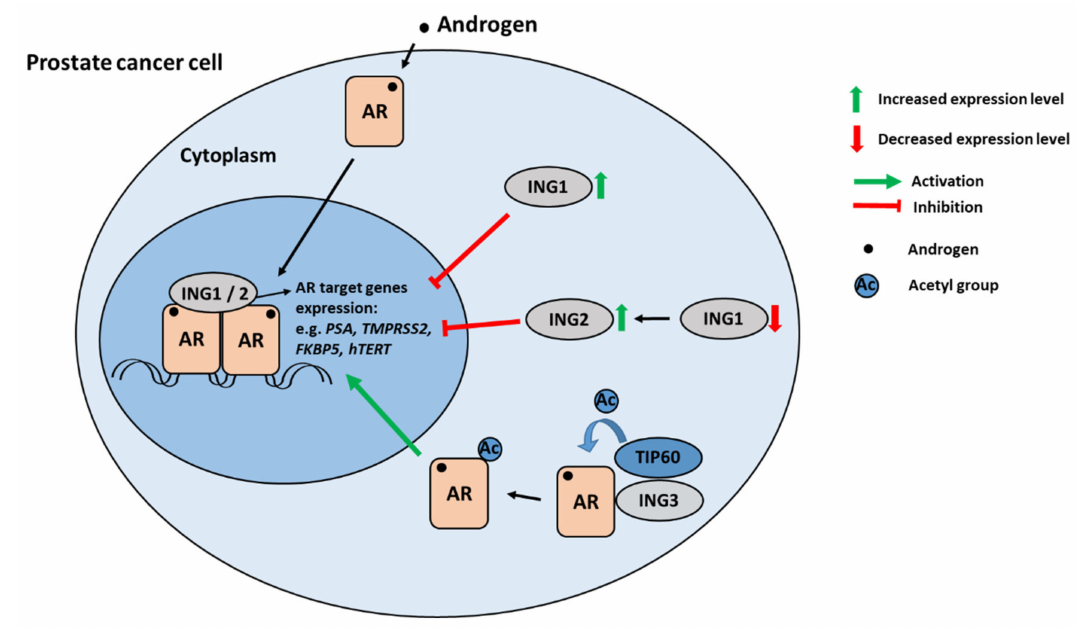
Figure 1. Schematic view of ING factors as coregulators of AR in PC. Androgens (black circle) bind to AR that translocates into the nucleus. ING1 and ING2 proteins interact with AR and serve as AR corepressors leading to reduced AR target gene expression of positively regulated AR target genes. Furthermore, ING1 and ING2 mediate the transrepression of the AR silenced target gene, hTERT [58]. On the other hand, ING3 acts as AR-coactivator, as it recruits Tip60 to AR that becomes acetylated (Ac), leading to enhanced